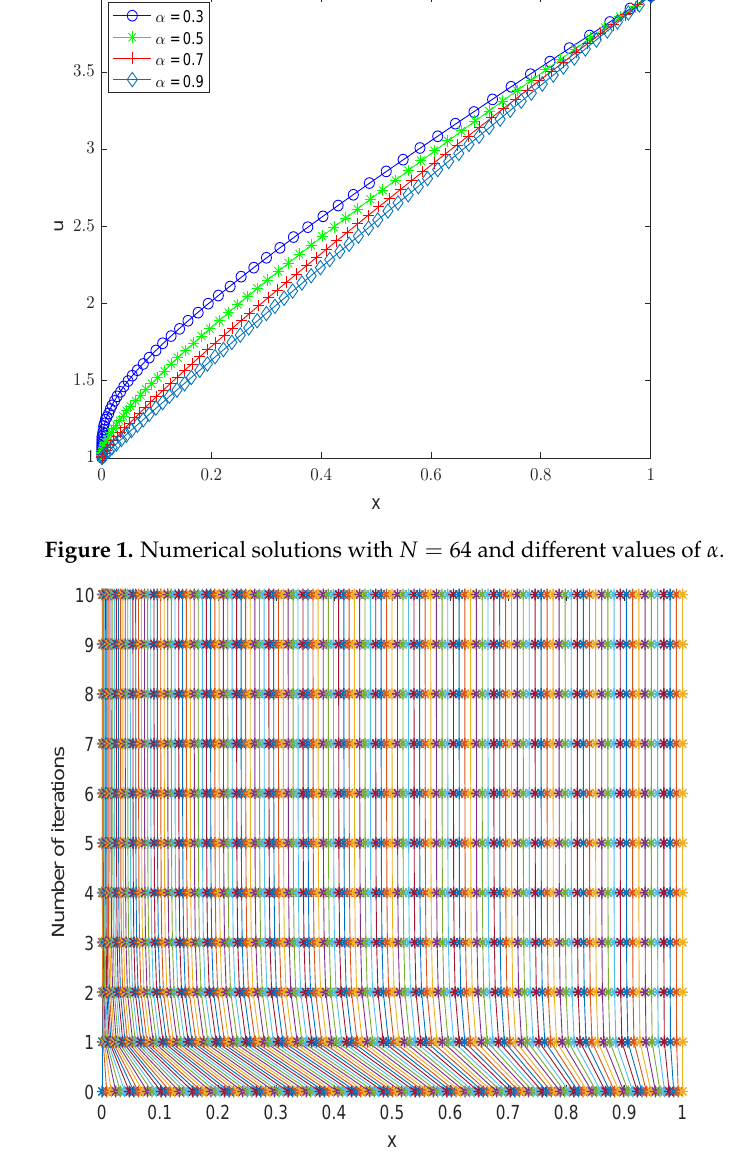
Figure 2. Evolution of mesh with α = 0.8 and N =